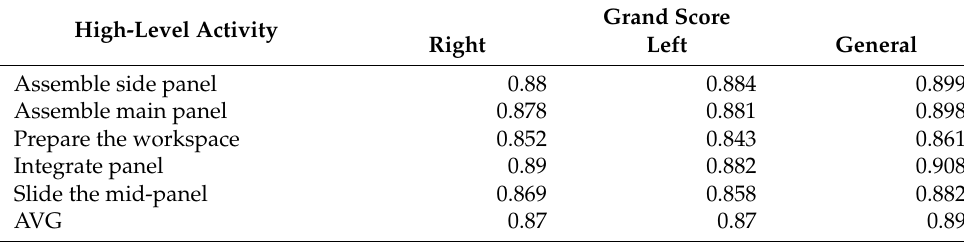
Table 9. Similarity measurement results for grand RULA